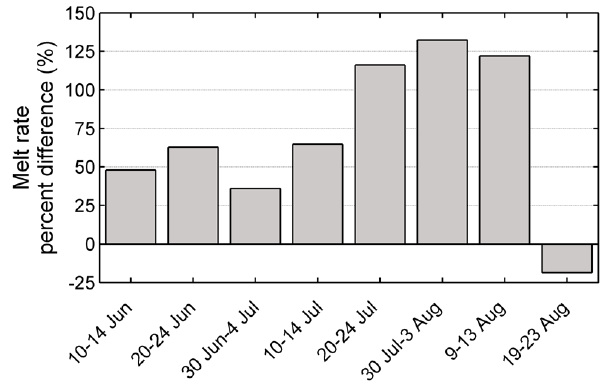
Figure 8. Percent difference in melt rate estimates for 100 × 100px 5-day average albedo distributions for the 2013 melt season relative to 31 May–4 June 5-day average albedo distribution. Melt rates are calculated with identical radiation budget conditions to isolate the effect of albedo distribution